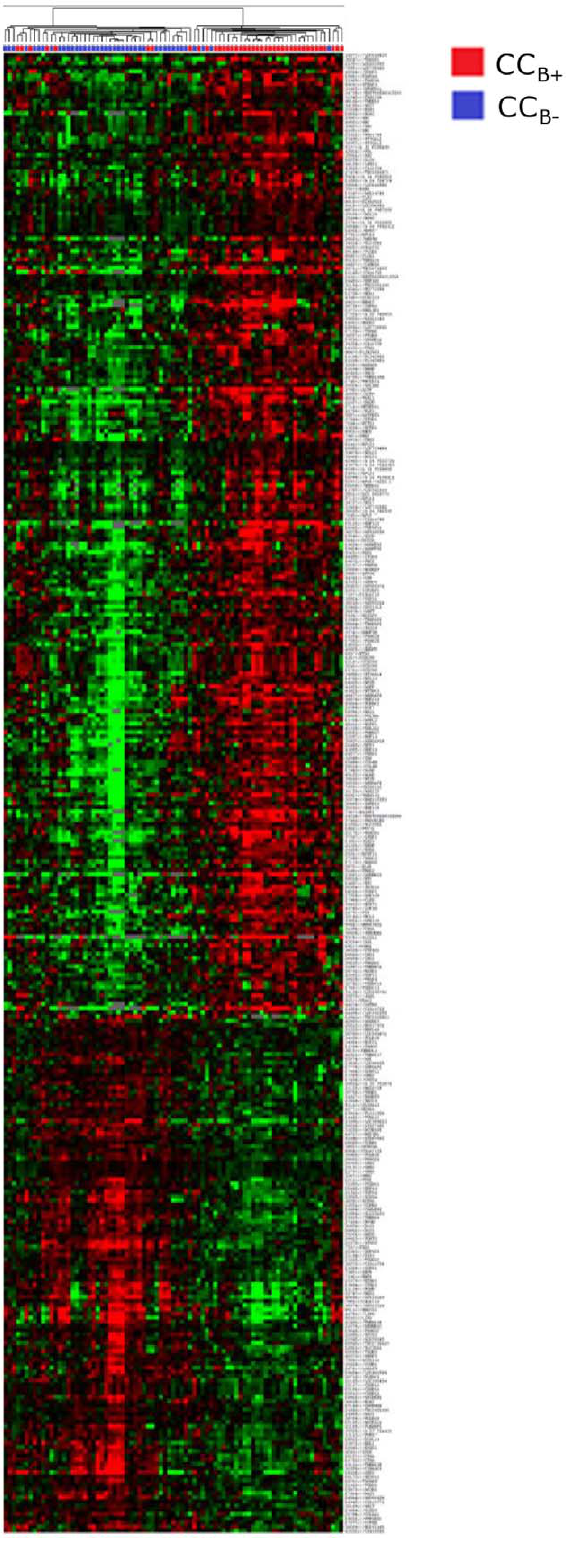
Figure 3. Heat map and cluster dendograms of gene clusters differentially expressed according to oocyte developmental competence. Hierarchical clustering of cumulus cell samples (col- umns) and the 354 most significant probes (rows). Upregulated genes are marked in red, downregulated genes are marked in green. CC B-